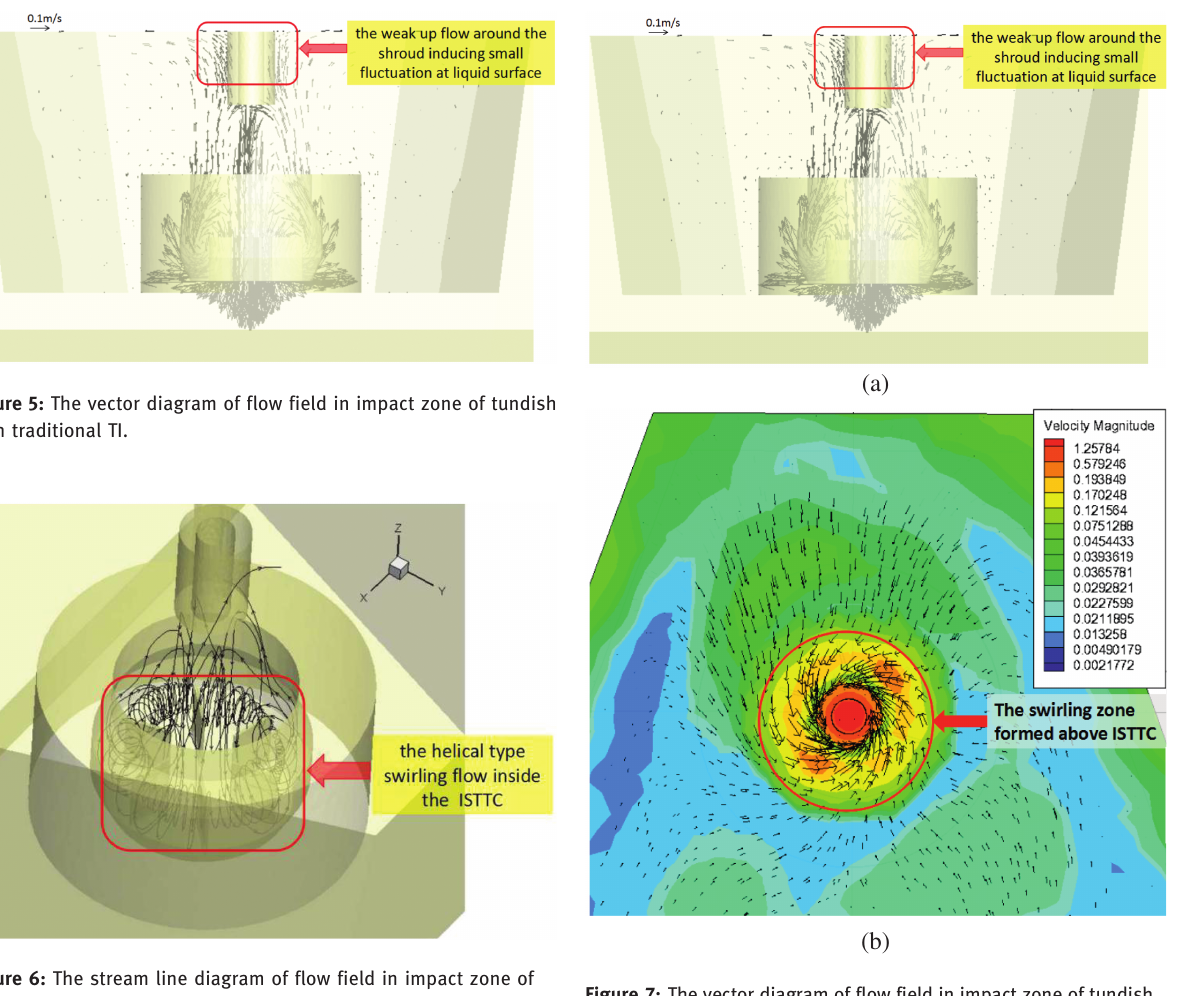
Figure 7: The vector diagram of flow field in impact zone of tundish with ISTTC. (a) Front view of impact zone (b) Top view of impact